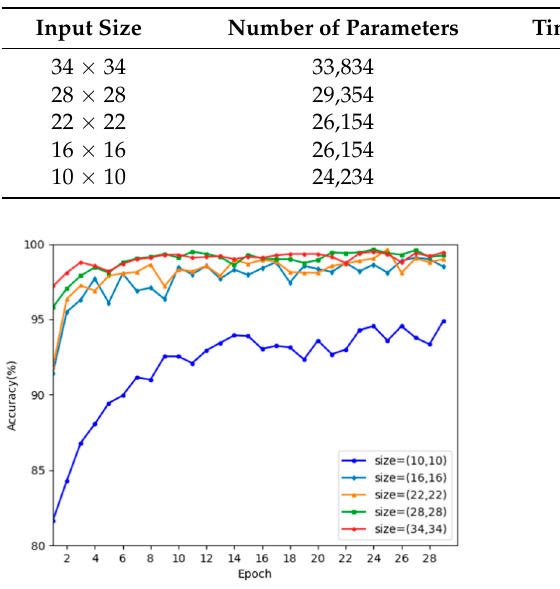
Figure 12. Training accuracy curve of different input sizes.